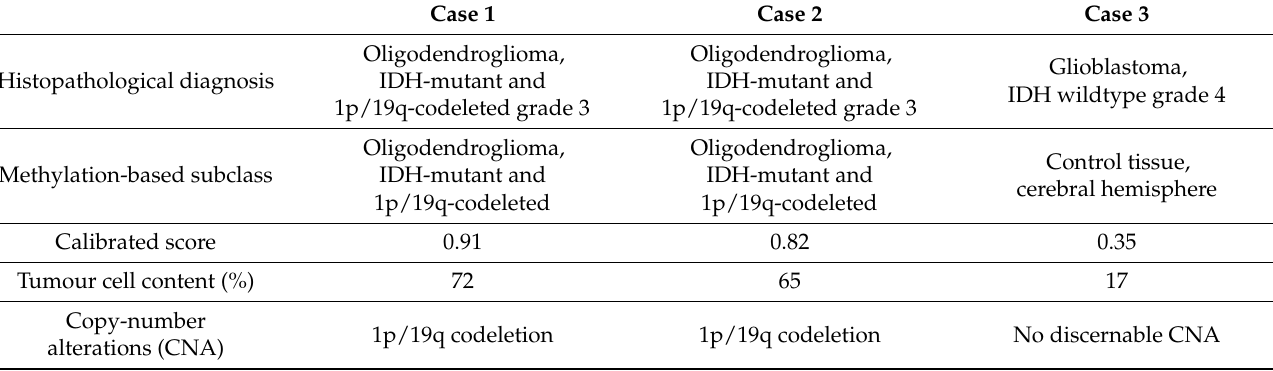
Table 3. Three examples of histopathological and methylation-based classification. Case 1 is success- fully classified by methylation above the threshold (0.9) with the same type as the histopathological diagnosis. Case 2, on the other hand, has a calibrated score just below the threshold. However, as the methylation-based diagnosis is the same as the histopathological diagnosis and supported by the 1p/19q codeletion in the CNA plot, the results are still useful and most likely true. Case 3 is a glioblastoma by histopathology (and a large tumour visible by radiological imaging), but is weakly indicated (calibrated score 0.35) as control tissue (i.e., non-tumour tissue) by methylation classification. Given the low calibrated score, low tumour purity and lack of CNA, the tissue sample used for DNA extraction is not representative of the tumour and, consequently, neither is the methylation-based